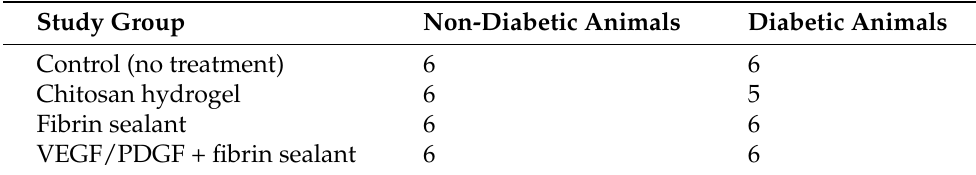
Table 1. Study groups and number of animals included in the analysis. Study